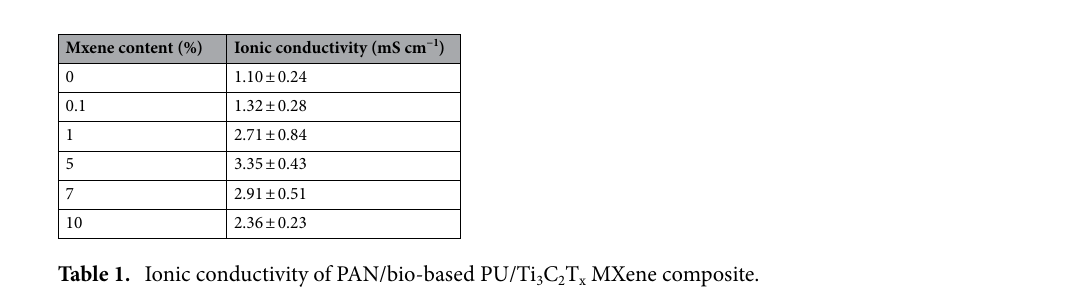
Table 1. Ionic conductivity of PAN/bio-based PU/Ti 3 C 2 T x MXene composite.